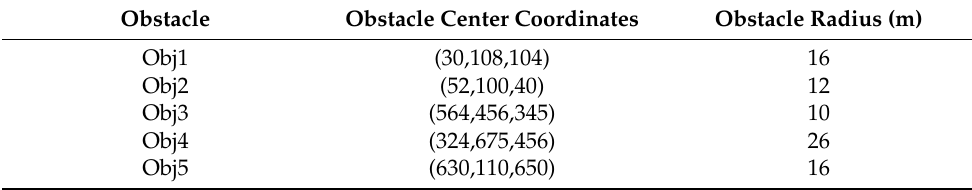
Table 1. Obstacle center coordinates.